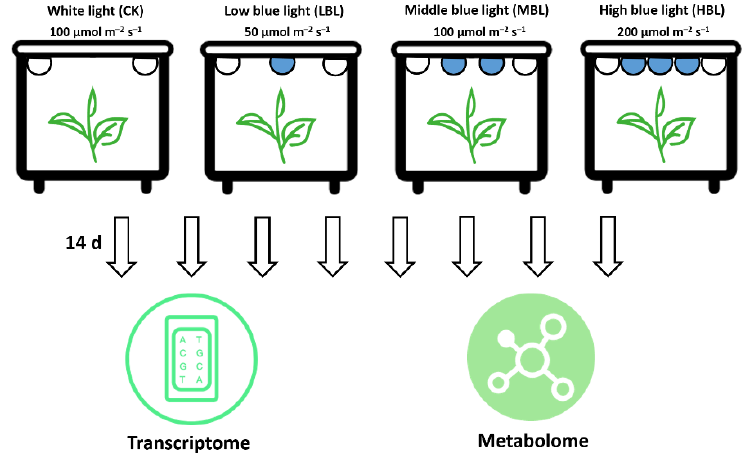
Figure 11. Schematic illustration of the treatment and omics analyses of tea plants under different blue LED light intensities.